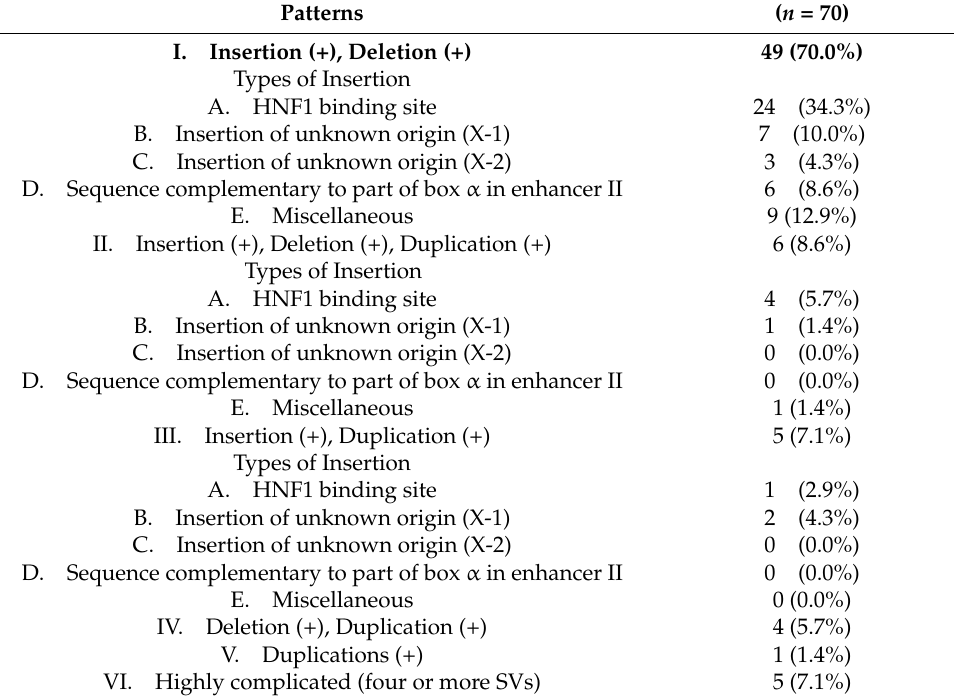
Table 1. Classification of HBV strains with complex